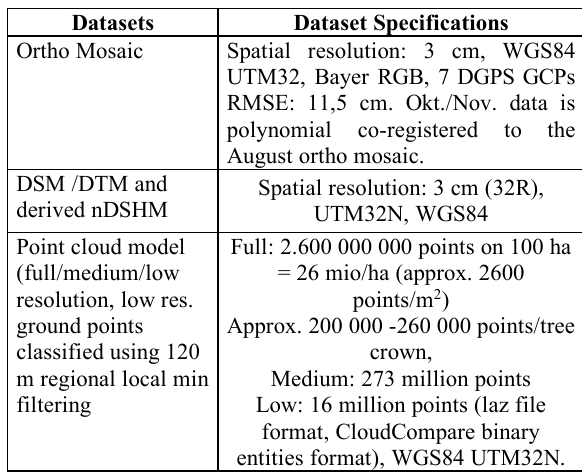
Table 3: UAV based georeferenced datasets processed from 612/625 images using Agisoft